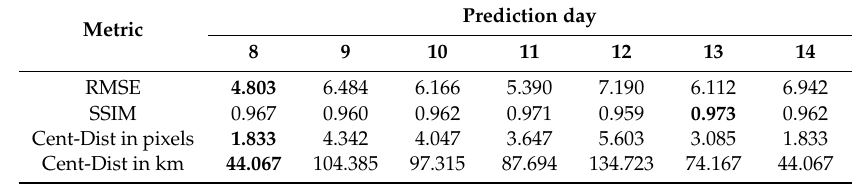
Table 12. Daily comparison of RMSE, SSIM, and centroid distance of case 2.